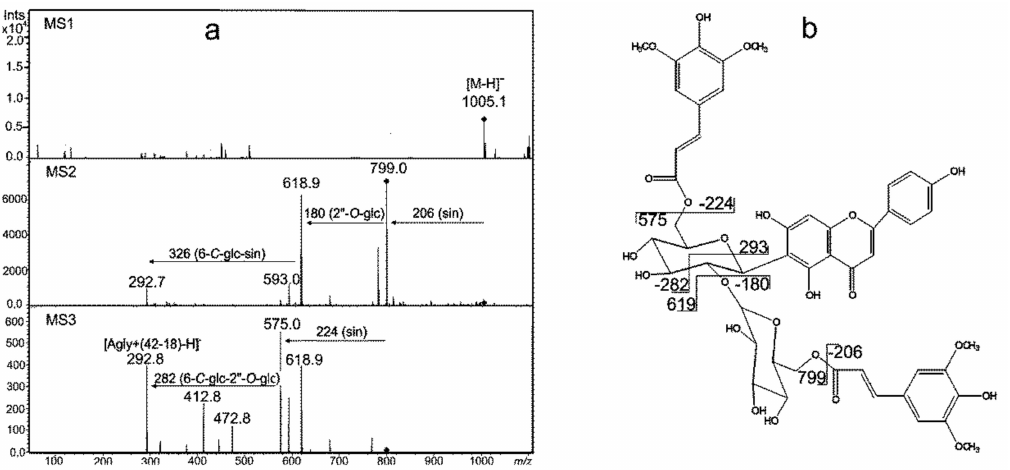
Figure 5. Mass spectra in negative ionization of compound 147, isovitexin 2”-O-glucoside disinapate ( a ) and putative fragmentation scheme ( b ) (Agly-flavone aglycon, glc-glucoside, sin-sinapic acid).